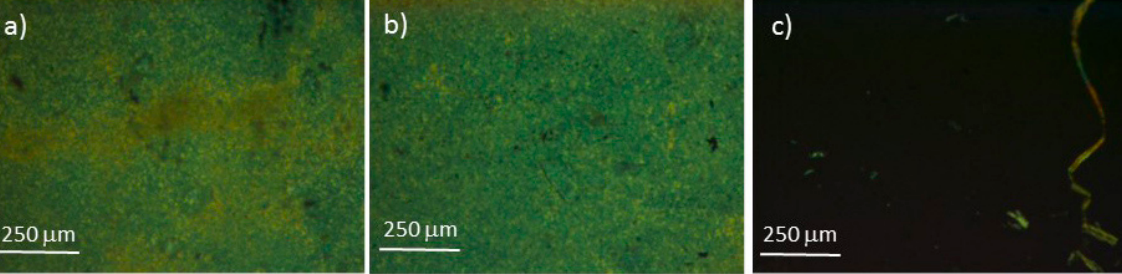
Figure 1. Optical micrographs under crossed polarizers of CP40 at 300 K ( a ), 335 K ( b ) and 433 K ( c ).